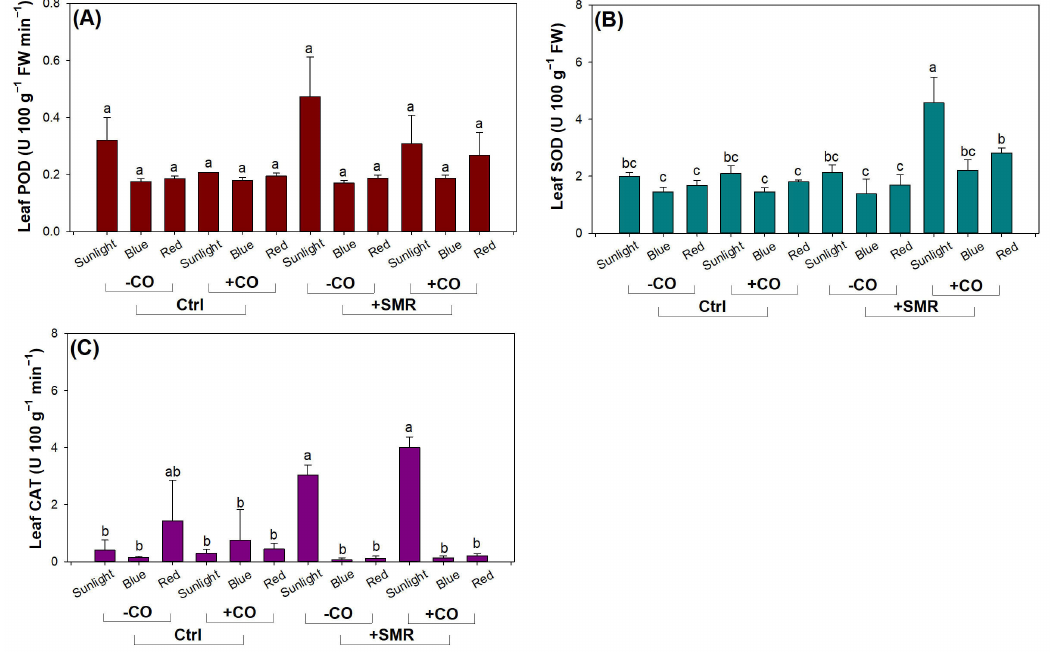
Figure 7. Leaf antioxidant activities in black chokeberry ( Aronia melanocarpa (Michx.) Elliott 1821) exposed to combined light-type (sunlight, blue light-emitting diode (LED), red LED), chitosan oligosaccharide (CO), and spent mushroom residue (SMR) treatments: ( A ) combined light, SMR, and CO effects on peroxidase (POD) activity; ( B ) combined light, SMR, and CO effects on superoxide dismutase (SOD) activity; ( C ) combined light, SMR, and CO effects on catalase (CAT) activity. Different letters mark significant difference according to Tukey test at 0.05 level.